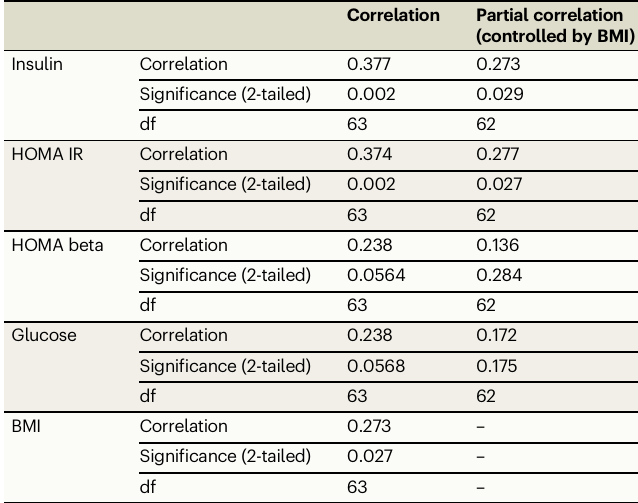
Table 1 | Correlation between human adipose tissue lactate concentration with clinical parameters Correlation Partial correlation (controlled by